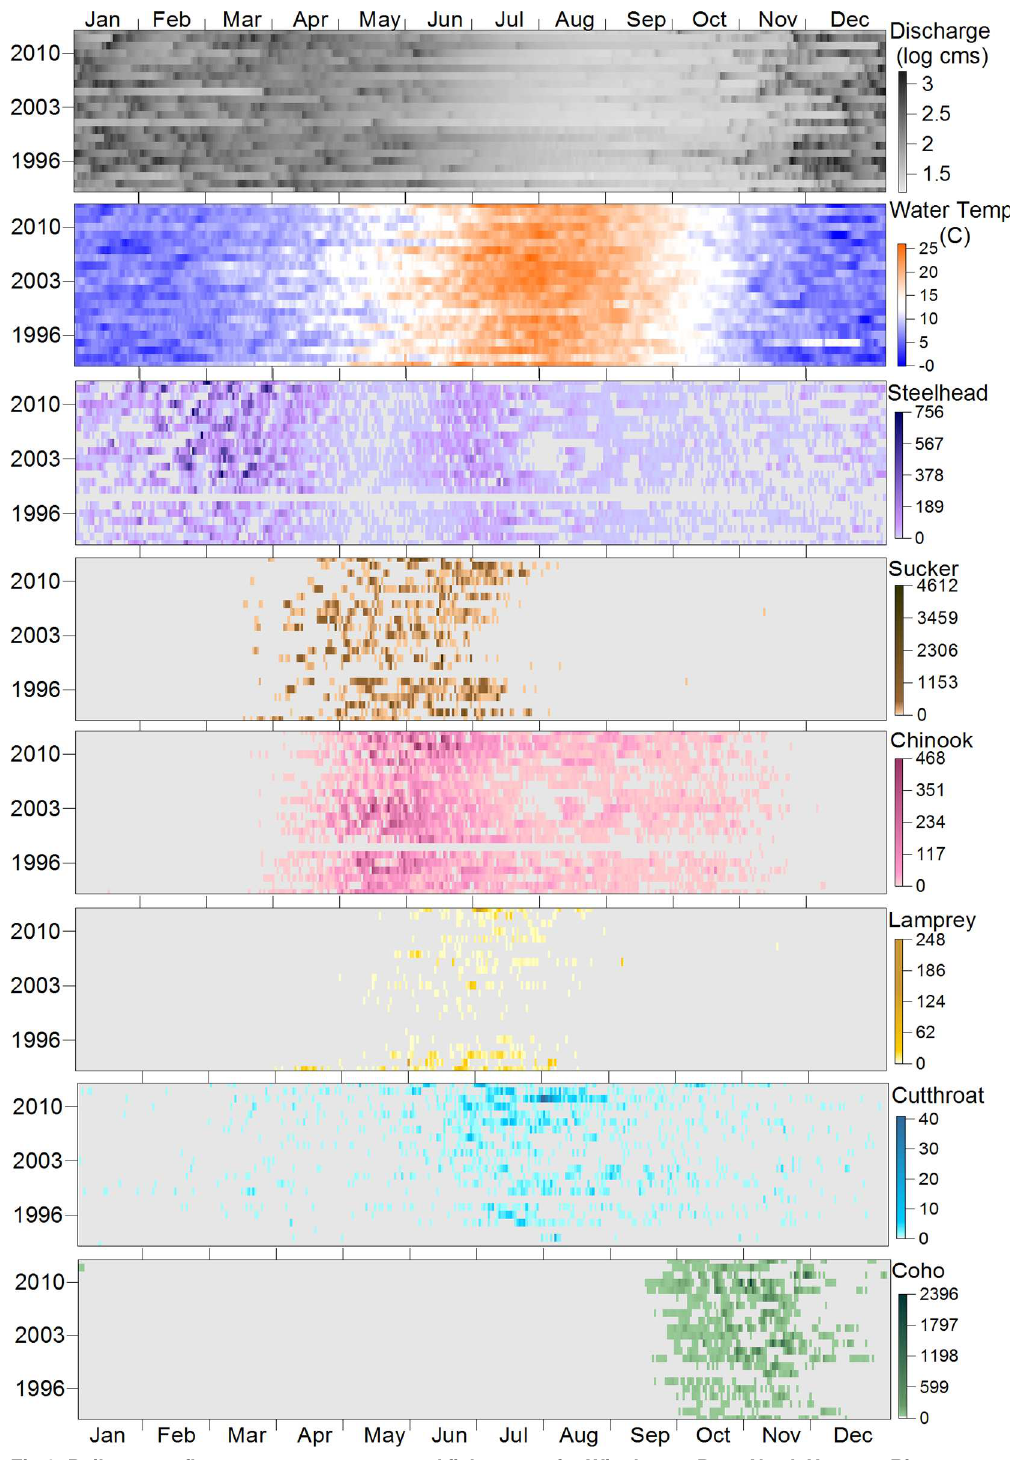
Fig 1. Daily streamflow, water temperature and fish counts for Winchester Dam, North Umpqua River, Oregon, USA from 1992 to 2013. Streamflow (top graph) from USGS gage station No. 14319500.Stream temperature (second graph from top) and fish counts courtesy Oregon Departmentof Fish and Wildlifefor, in order: steelhead(anadromous Oncorhynchus mykiss ), sucker ( Catostomus macrocheilus ), ChinookSalmon ( Oncorhynchus tshawytscha ), lamprey ( Entosphenus tridentatus ), cutthroat trout ( Oncorhynchus clarkii ), and